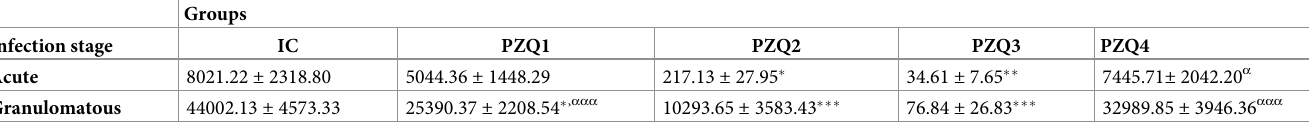
Table 3. Effect of praziquantel treatment on egg retention in tissue in Schistosoma mansoni- infected in mice.